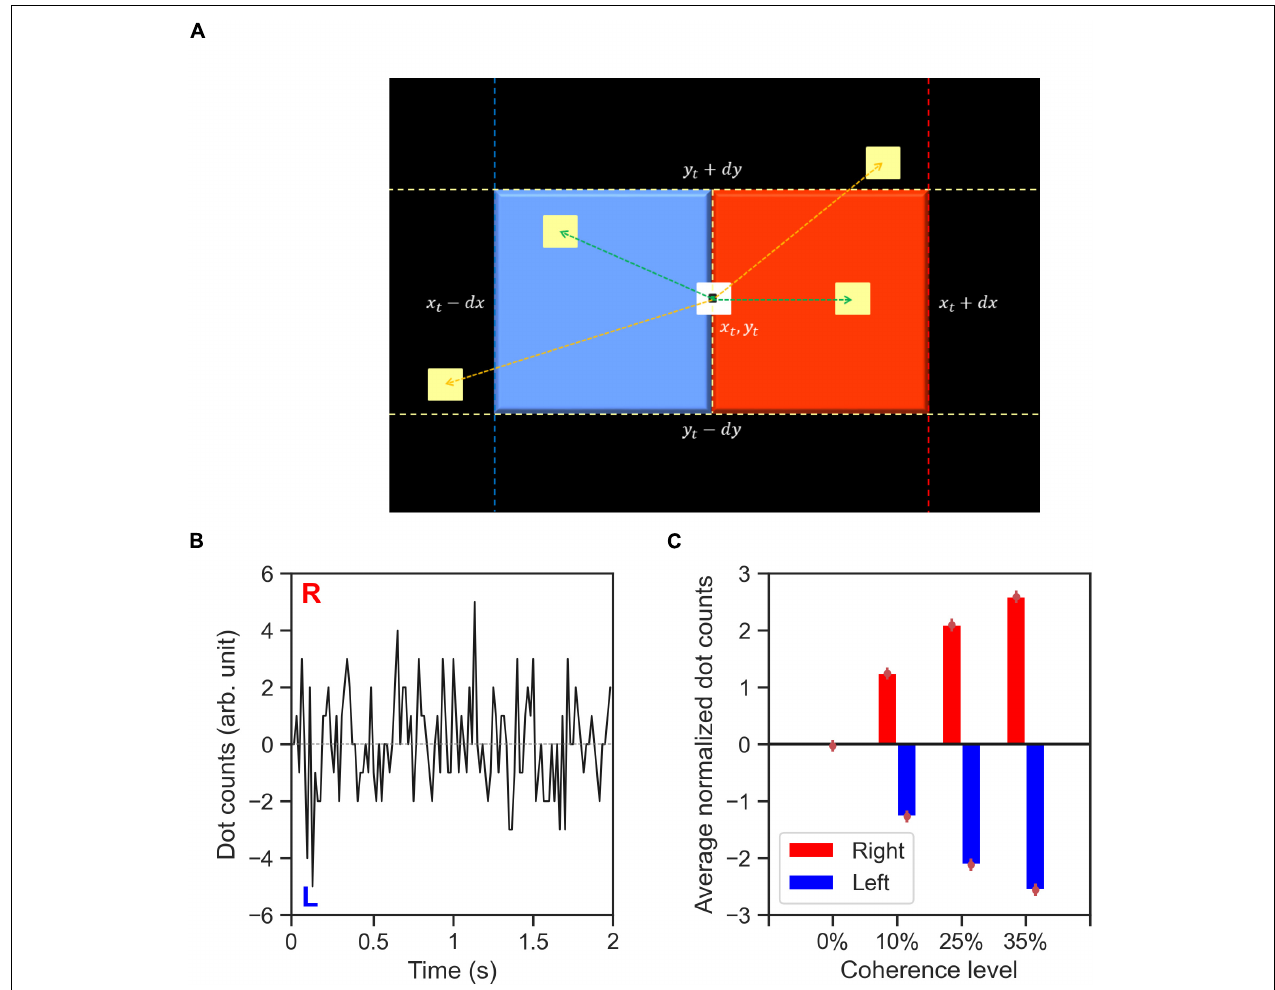
FIGURE 8 | The dot counting algorithm and stimulus features. (A) Schematic of dot counting algorithm: the algorithm iterates through every dot within the stimulus aperture at every time-step, t . If within a time period of 50 ms (up to three frames) after t there exists a dot within a square area to the right of the current dot (red area), the dot movement is rightward (green arrow to a yellow dot within the red area) and the dot counts (DC) for the respective time-step, dc ( t ) , is incremented. Likewise, if within the similar time period there exists a dot within the area to the left of the current dot (blue area ) , the dot movement is leftward (indicated by green arrow to the yellow dot within the blue area) and the dc ( t ) is decremented. The dot movements outside of the red and blue areas (indicated by orange arrows) dot not contribute to the value of dc ( t ) for the dot currently being considered, (B) a representative example time-course of the computed DC for a single trial with 0% coherence stimulus type 6. The labels R and L indicate the directions encoded by the DC features. (C) Average normalized DC values shown as a function of coherence level and trial-wise direction of correct alternative. The normalized DC values are computed as the DC values divided by the standard deviation of absolute dot count values across all trials containing stimuli of the same coherence level. The average value of normalized DC is then computed across all trials related to the coherence level with the respective direction of correct alternative (right or left). Error bars indicate the standard error of the mean.